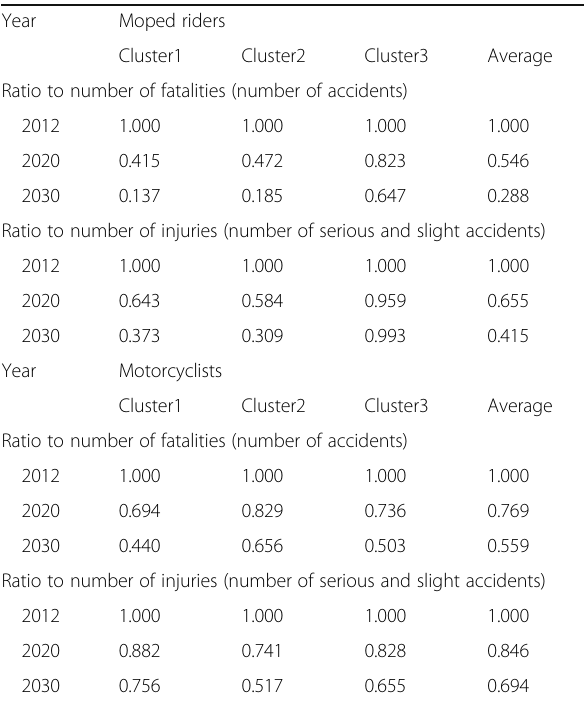
Table 3 Ratio of predicted 2020 and 2030 moped rider and motorcyclist accidents to every 1 moped rider / motorcyclist accident in